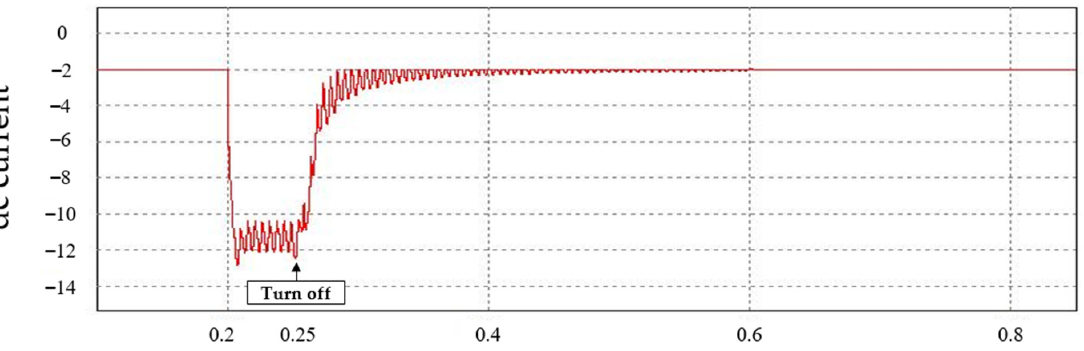
Figure 13. Simulation results of the DC side of an MMC.